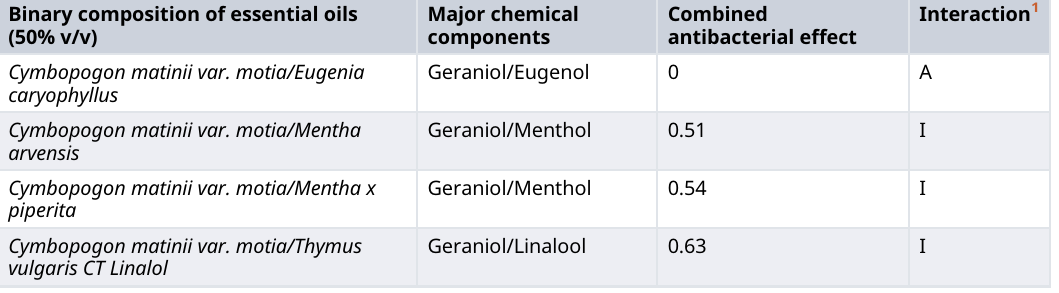
Table 5. Interaction among essential oils against B. subtilis growth. Fractional inhibitory concentration and interaction among essential oil major components Binary composition of essential oils (50%